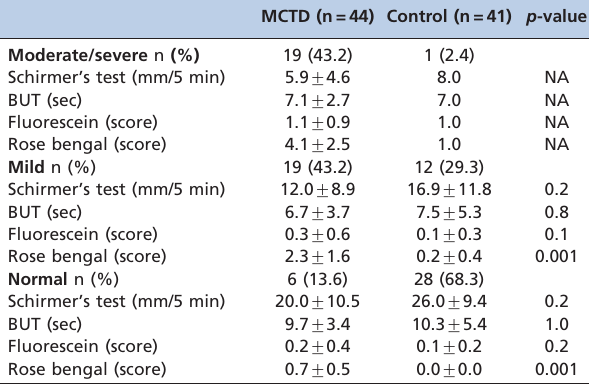
Table 2 - Severity grading of dry eyes in MCTD patients and